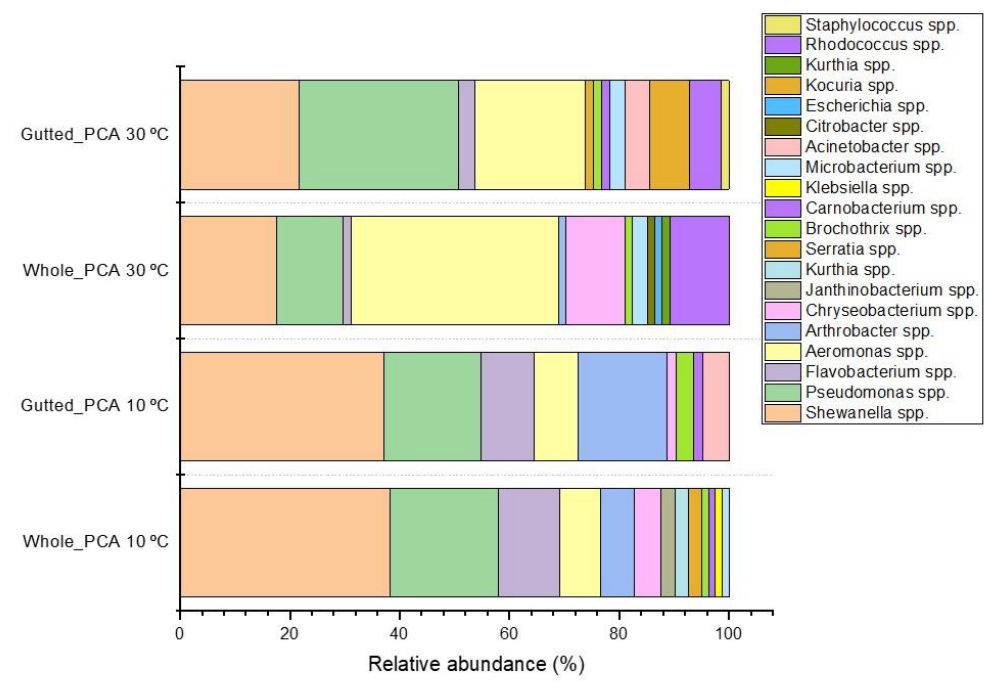
Figure 1. Relative abundance of the dominant bacterial colony types isolated from PCA and identified at genus level with MALDI-TOF or 16S rRNA gene sequencing.